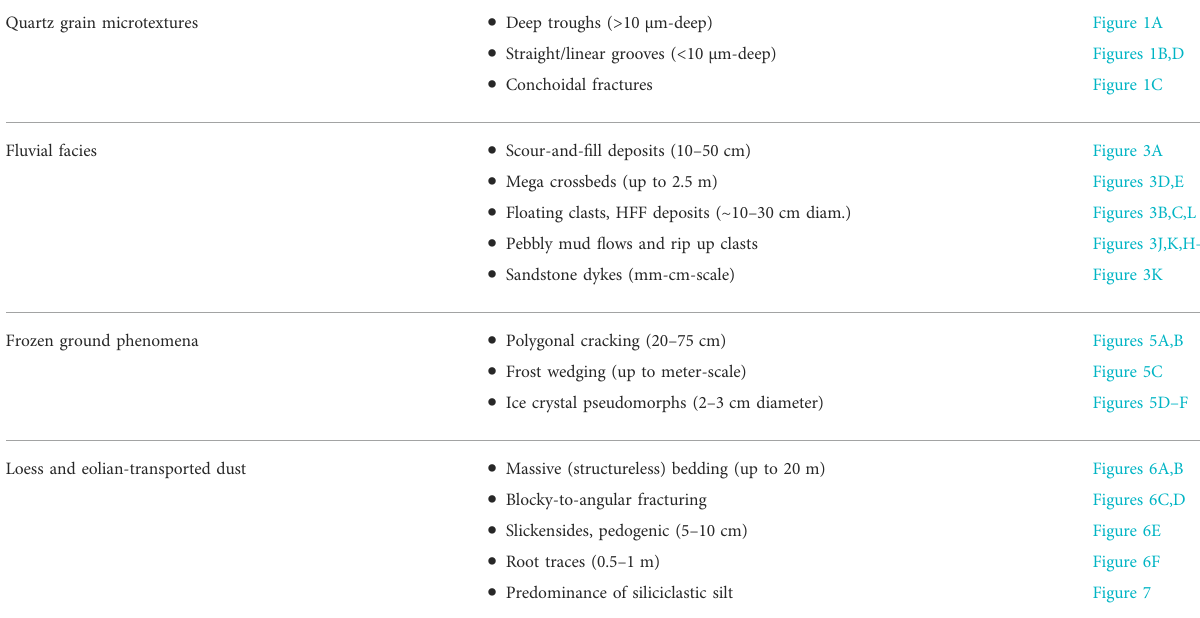
TABLE 1 Attributes of pro- and periglacial settings illustrated in this paper. Quartz grain microtextures (cid:129) Deep troughs ( > 10 µm-deep) Figure 1A